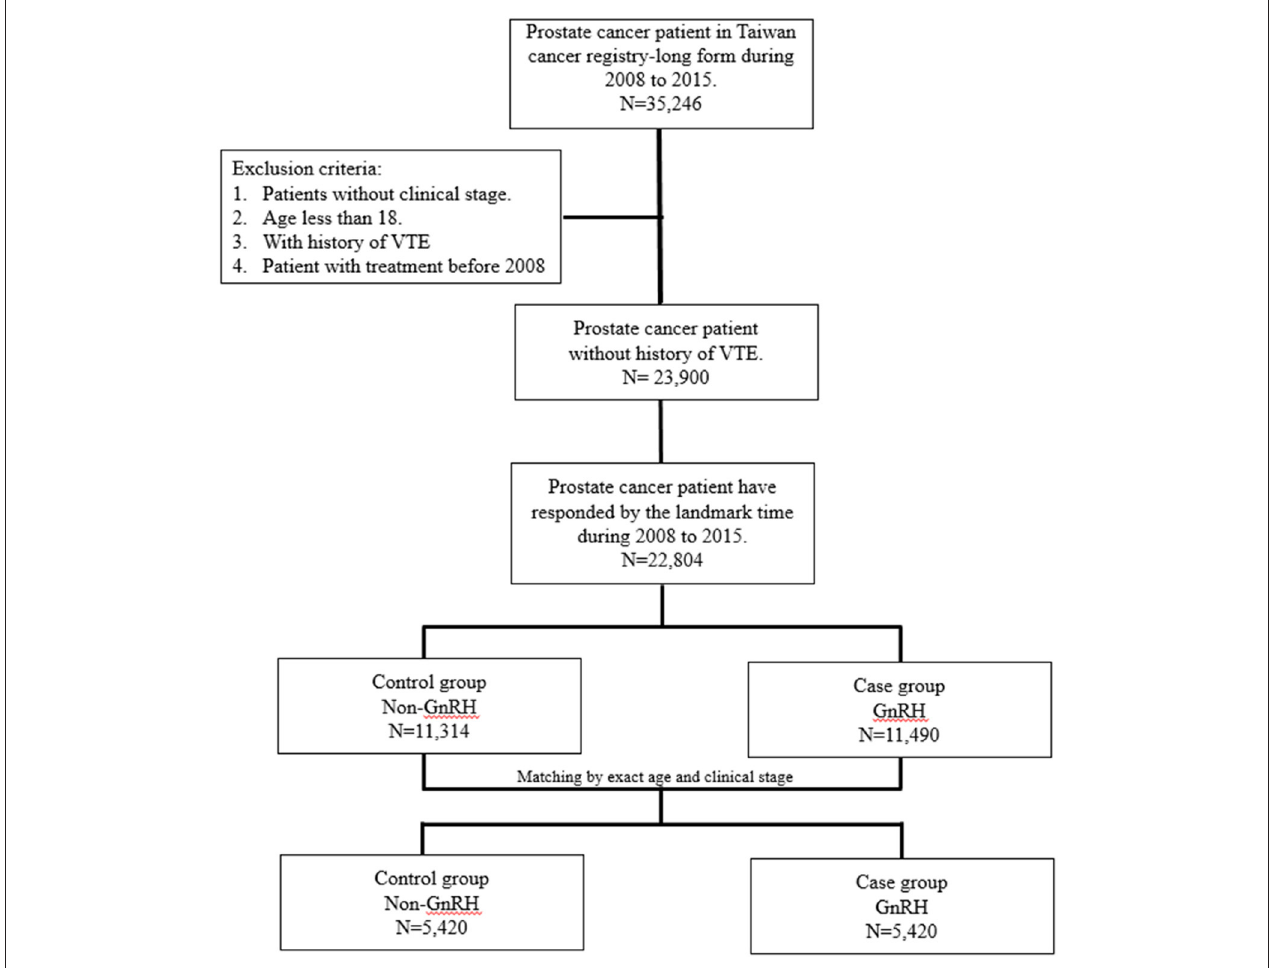
FIGURE 1 | Study flow